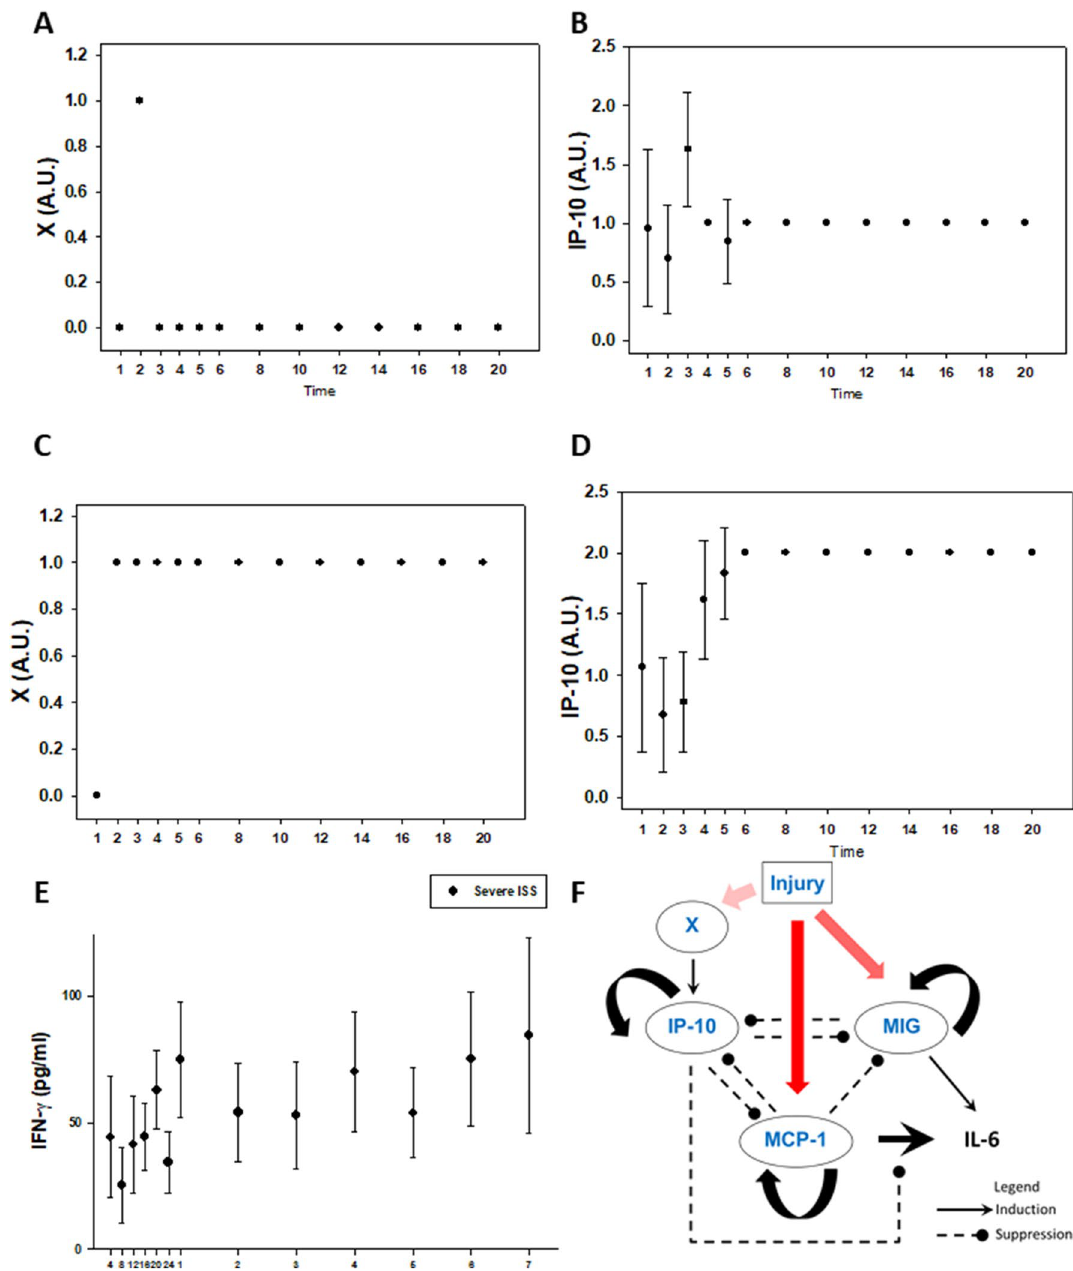
Figure 4. Addition of a putative node improves IP-10 simulations. A new variable, X , was added upstream of IP-10 to introduce a delay due to the observed slow rise in patient IP-10 trajectory. A spiky trajectory for X (Panel A ) produces an IP-10 trajectory (Panel B ) that is inconsistent with patient data. A step rise for X (Panel C ) produces an IP-10 trajectory (Panel D ) that matches well with patient data. Coincidentally, out of the measured inflammatory mediator profiles, the trajectory of circulating IFN- γ most closely resembles a step increase trajectory (Panel E ). (Panel F ): Model schematic with addition of new variable X